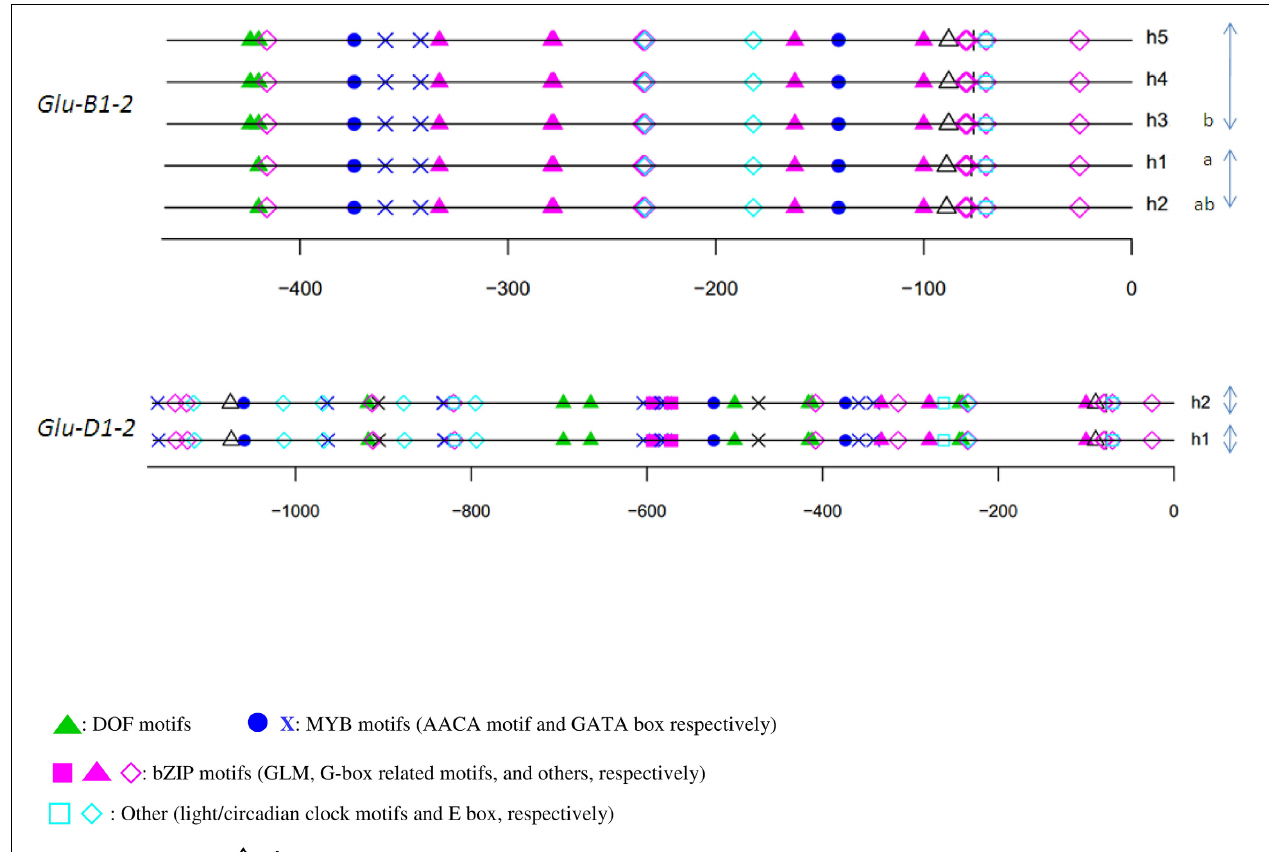
FIGURE 4 | In silico annotation of the y-type HMW-GS gene promoter haplotypes. Positions are indicated relative to the transcription start site. Sequences were obtained from a set of 42 lines representative of the genetic diversity of the INRA worldwide hexaploid wheat core collection. For each gene, the haplotype of the